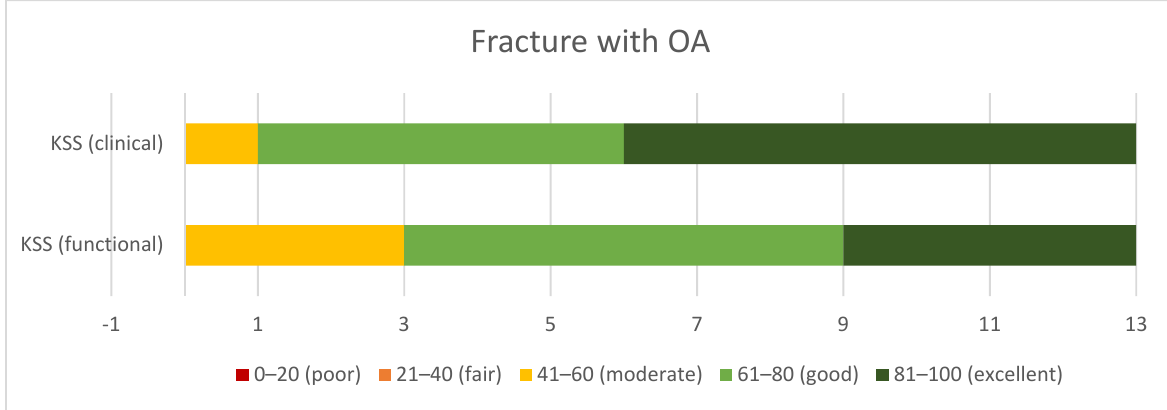
Figure 5. Clinical and functional outcomes in KSS in the group of patients with fracture and coexisting osteoarthritis.